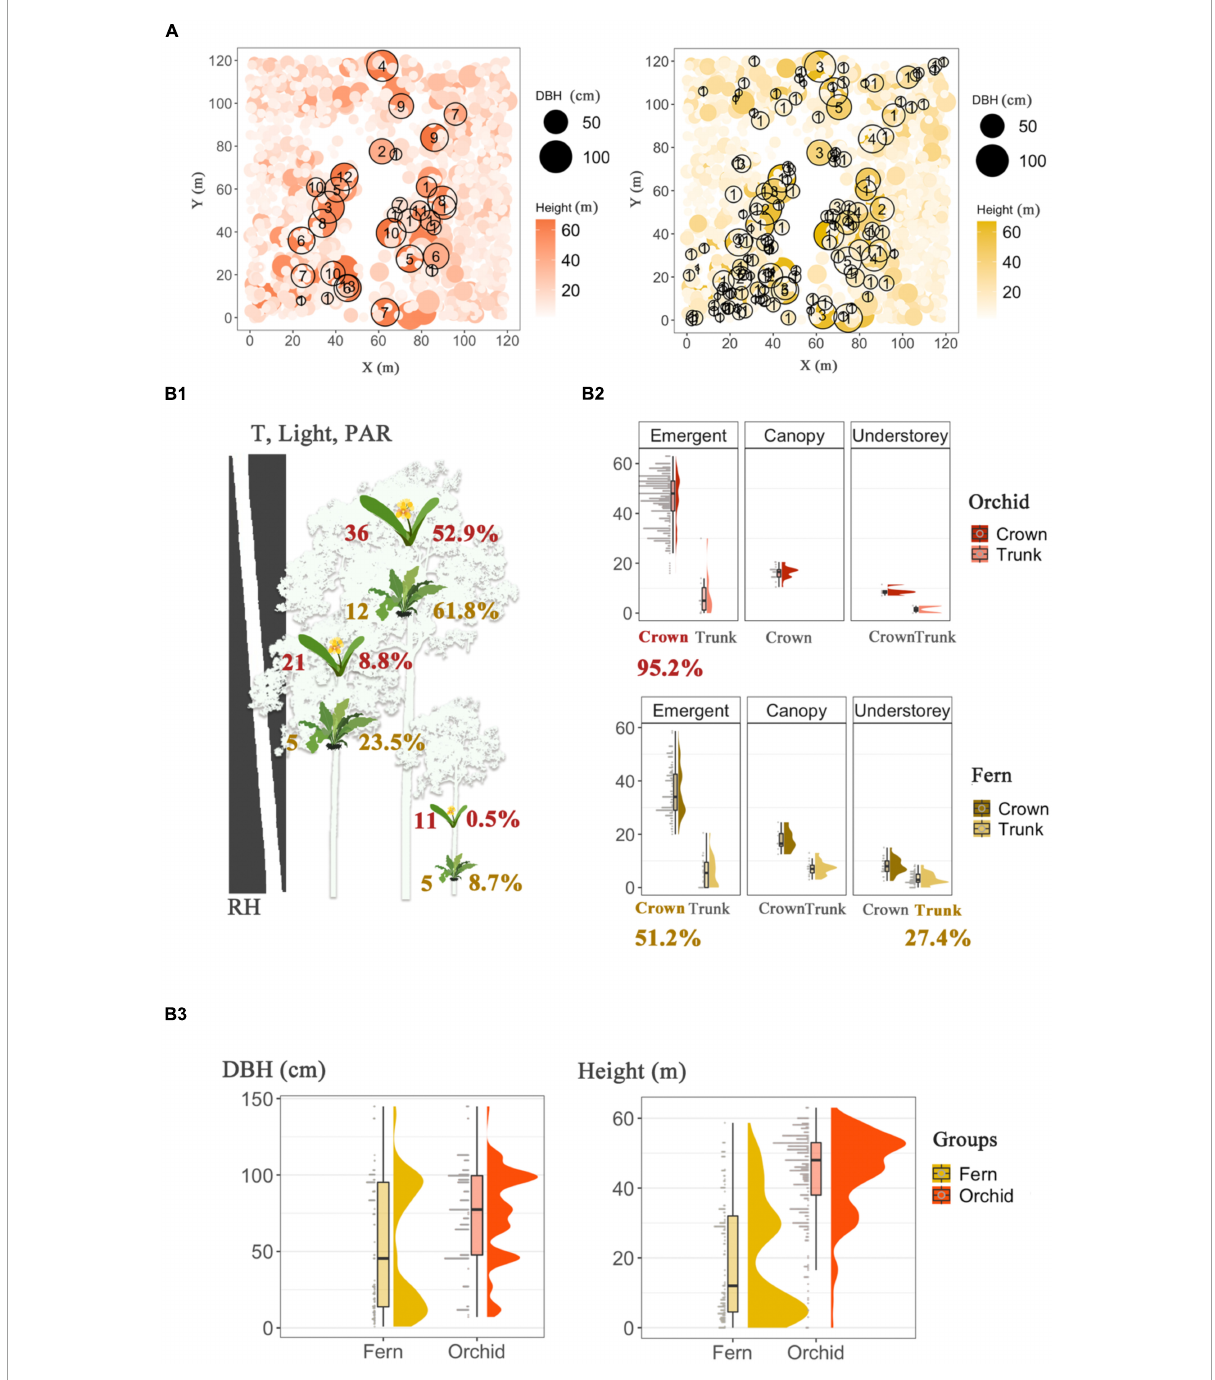
FIGURE1 Horizontal and vertical distribution of epiphytic spermatophyte and fern richness and abundance on individual trees in a 1.1 ha tropical canopy crane facility, Yunnan, SW China. (A) Horizontal distribution of epiphyte spermatophytes (left) and fern (right) richness on individual trees in a x-y space (120 m ∗ 120 m) depending on DBH and tree height. (B1) Vertical distribution of epiphyte richness and the ratio of epiphytic individuals on canopies or trunks to the total number of epiphytic individuals controlling for tree size. (B2) Box plots [showing the 1st and 3rd quartiles (upper and lower bounds), 2nd quartile (center), 1.5 ∗ interquartile range (whiskers) and minima-maxima beyond the whiskers] of the number of individuals controlling for tree layers and tree structures. (B3) Histogram of species abundance of two groups depending on DBH and height, respectively. Gray triangles represent relative humidity (RH), temperature (T), light intensity (Light) and photosynthetically active radiation (PAR) along a